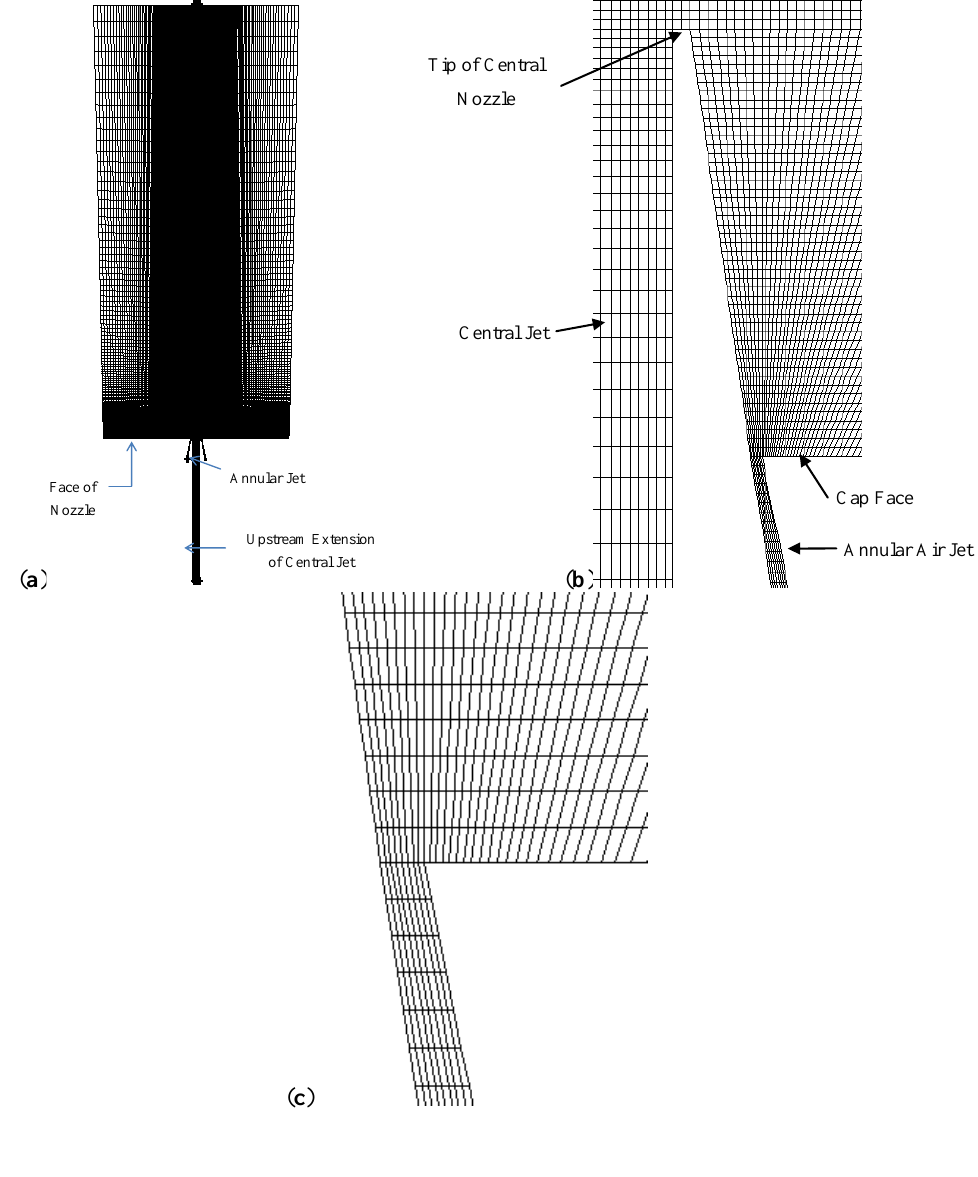
be resolved on this scale in the solid black area); ( b ) Close up of the mesh at the origins of the central and annular jets in the horizontal plane of symmetry (dimensions given in Table 1); ( c ) Close up of the mesh at the origin of the annular jet in the horizontal plane of symmetry (dimensions given in Table 1); ( d ) Downstream domain end mesh; ( e ) Core of domain shown in